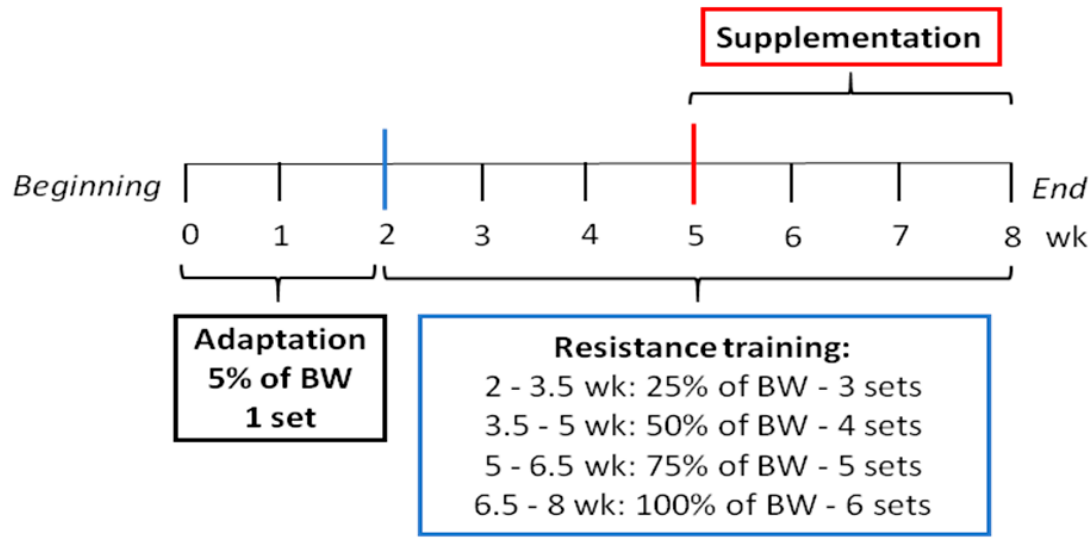
Figure 1. Resistance training protocol and experimental design. Abbreviations: BW: body weight; WK: week.